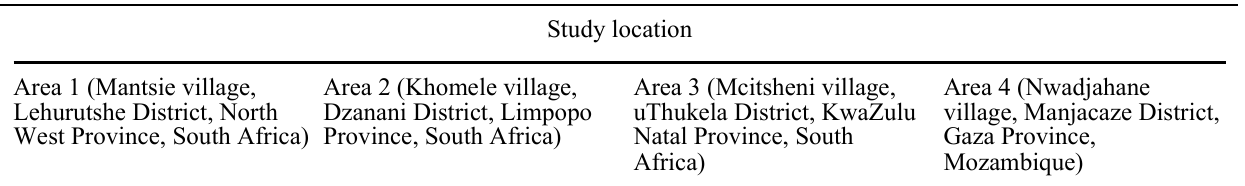
Table 1. Summary of livelihood risks across the study areas.